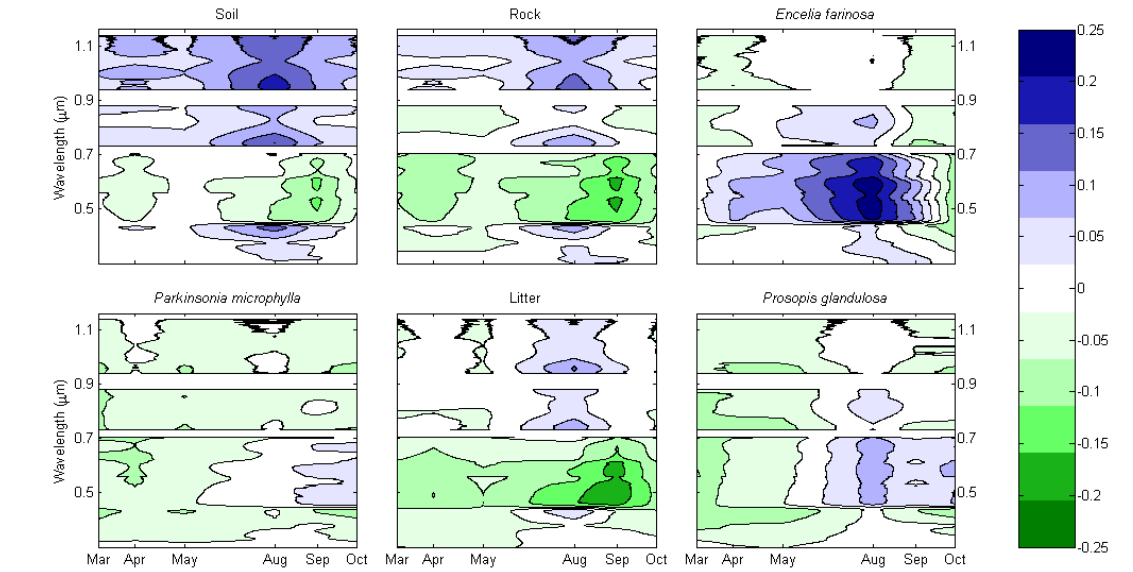
Figure 6. Reflectance differences of six abundant cover types by time (y-axis) and wavelength (x-axis). Positive values (blue) indicate the target is more reflective than P. ciliare for the given wavelength and acquisition date while negative values (green) indicate that P. ciliare is